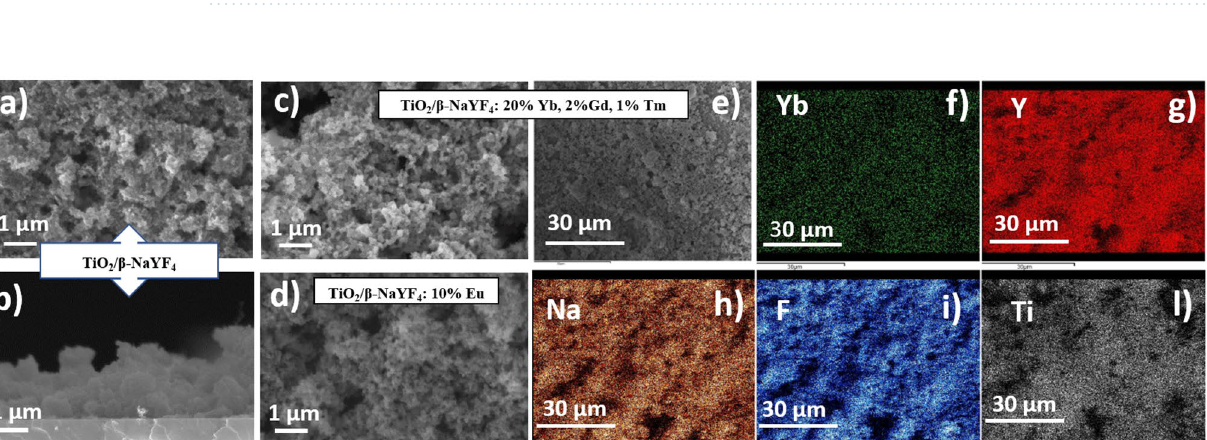
Table 1. List of samples used to photo-degrade an aqueous solution 1.8 × 10 –5 M MB under visible and UV light irradiation.